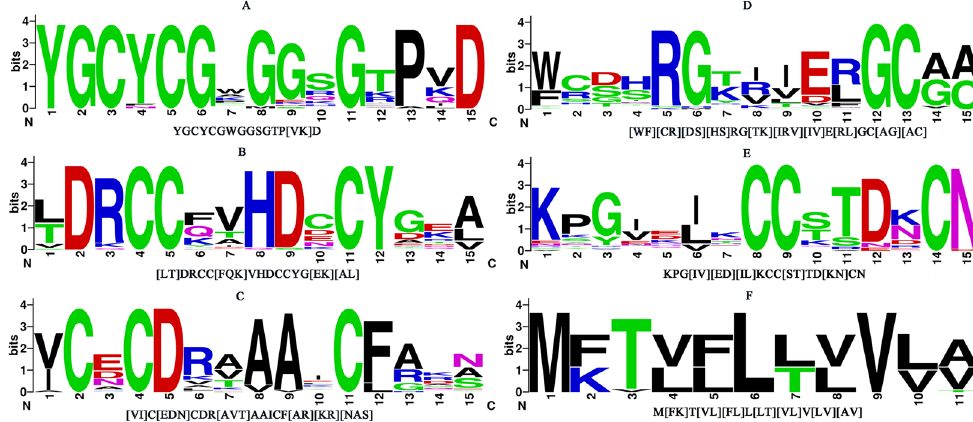
Figure 2. MEME motifs for ( A ) presynaptic neurotoxins motif 1, ( B ) presynaptic neurotoxins motif 2, ( C ) presynaptic neurotoxins motif 3, ( D ) postsynaptic neurotoxins motif 1, ( E ) postsynaptic neurotoxins motif 2, and ( F ) postsynaptic neurotoxins motif 3 in logo format. The regular expression for each MEME motif was shown at the bottom of each